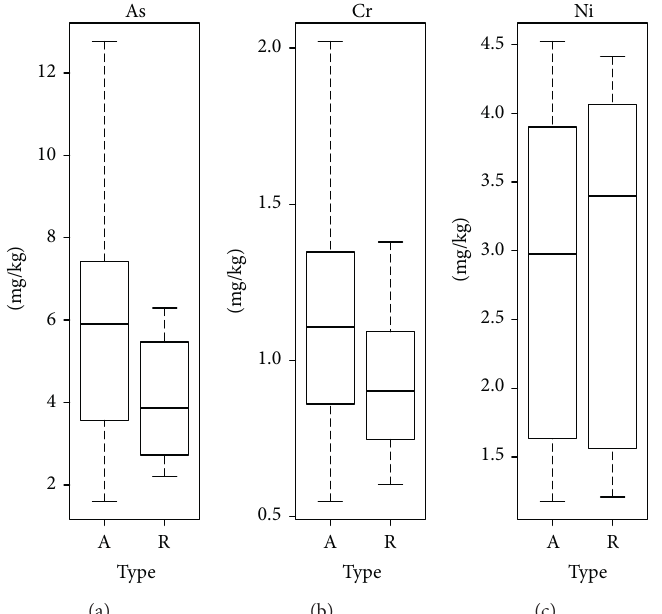
Figure 5: Box and Whisker plots for bioaccessible As, Cr, and Ni stratified by location type; “A” represents allotment land use and “R” represents residential land use. The bar shows the median